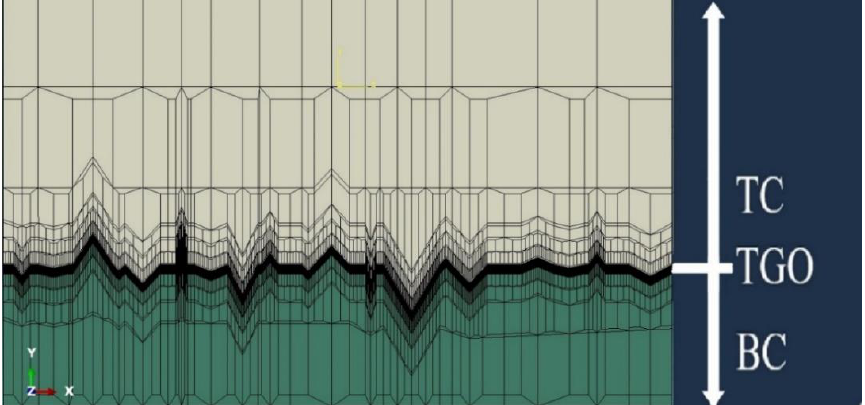
Figure 35. Generalized roughness model using a randomly distributed roughness profile.